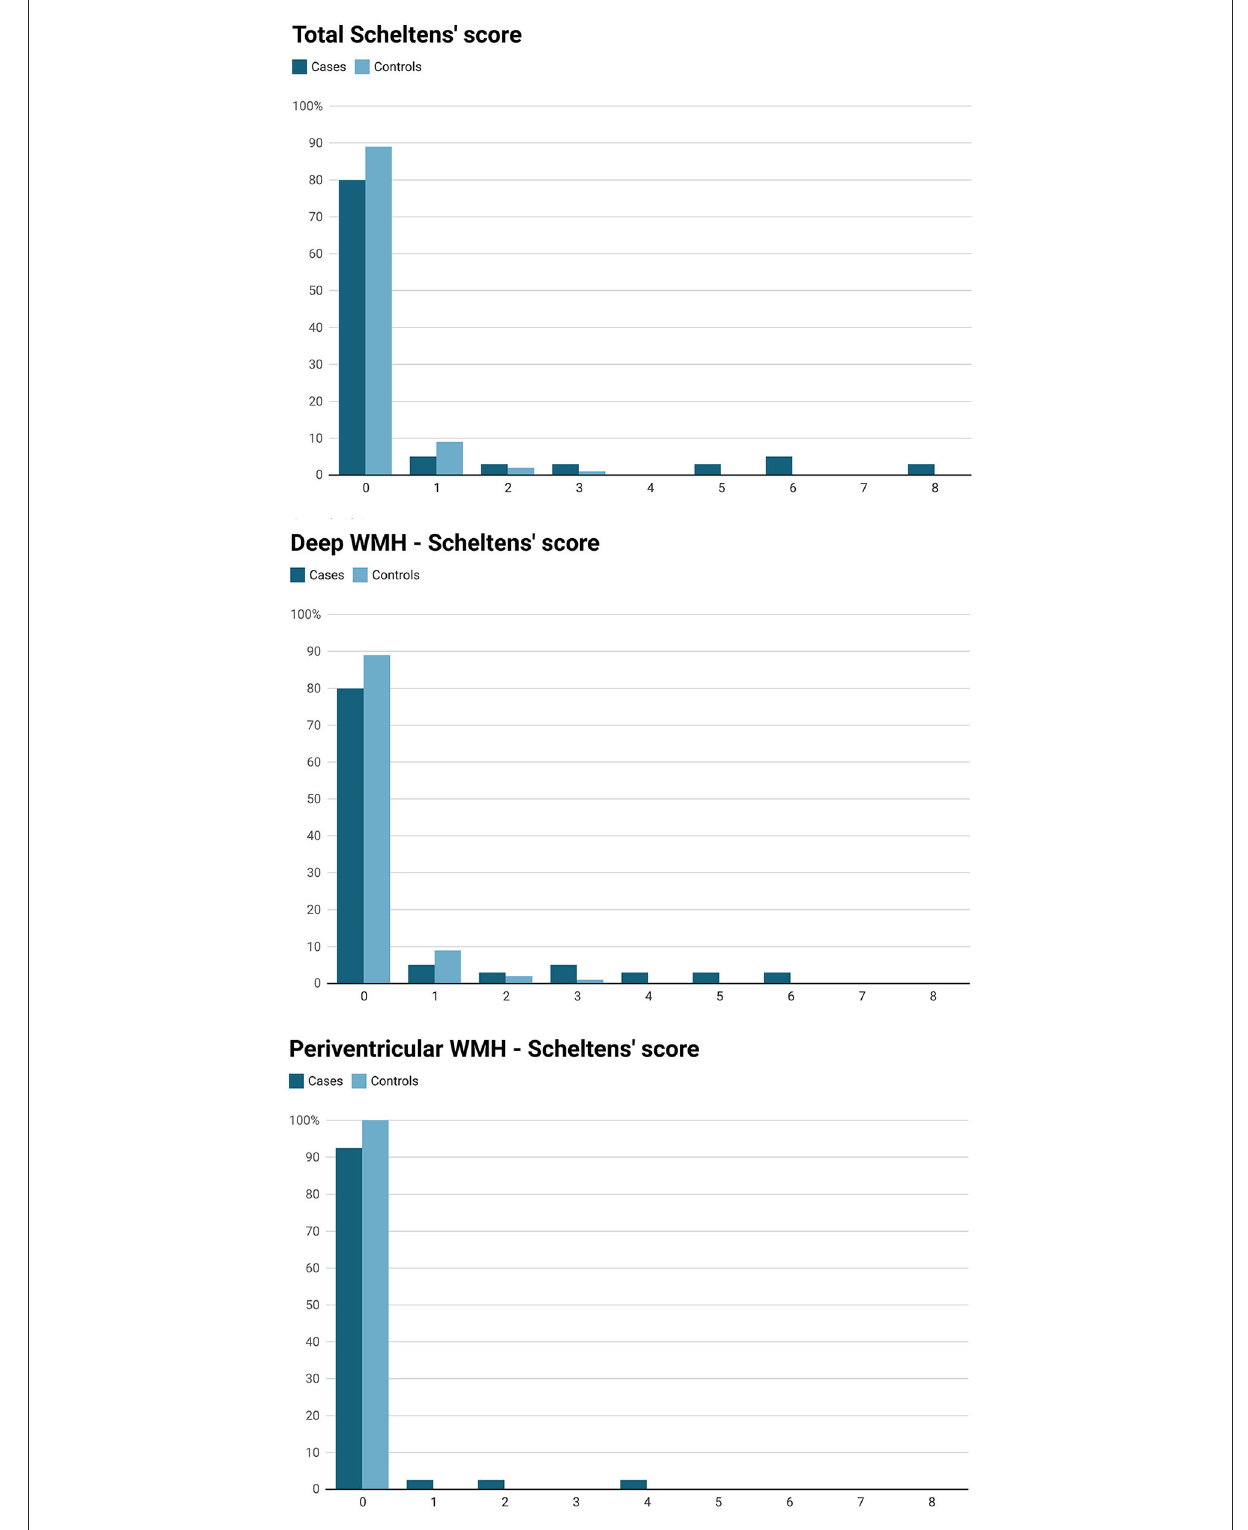
FIGURE1 White matter hyperintensity scores (WMH) assesed by Scheltens’ visual rating scale in 40 cases (Kawasaki disease) and 160 controls (migraine